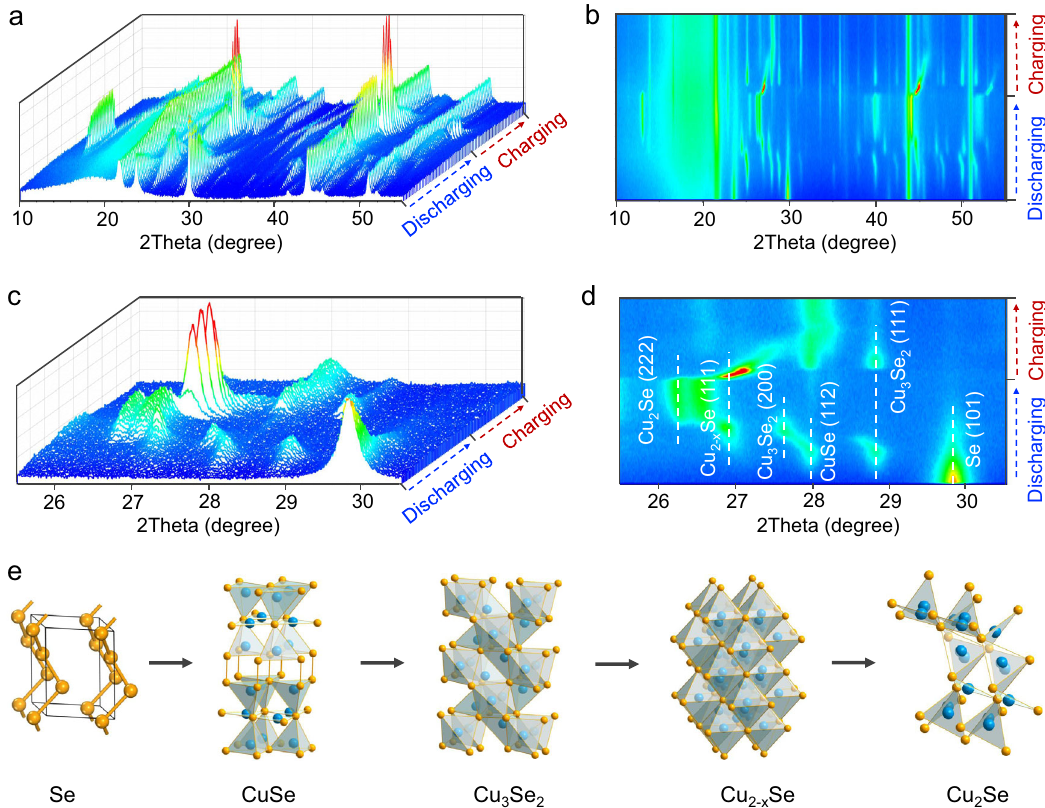
Fig. 4 The working mechanism of the Cu|0.5 M CuSO 4 |Se@C-78 coin cells. a and b Full patterns of in situ XRD between 10 and 55° during a whole discharging-charging process. c and d In situ XRD patterns between 25.5 and 30.5° to show the sequential conversion of Se to CuSe, Cu 3 Se 2 , Cu 2 − x Se, and Cu 2 Se during the discharging process. e Schematic illustration of structure transition of Se during the discharging